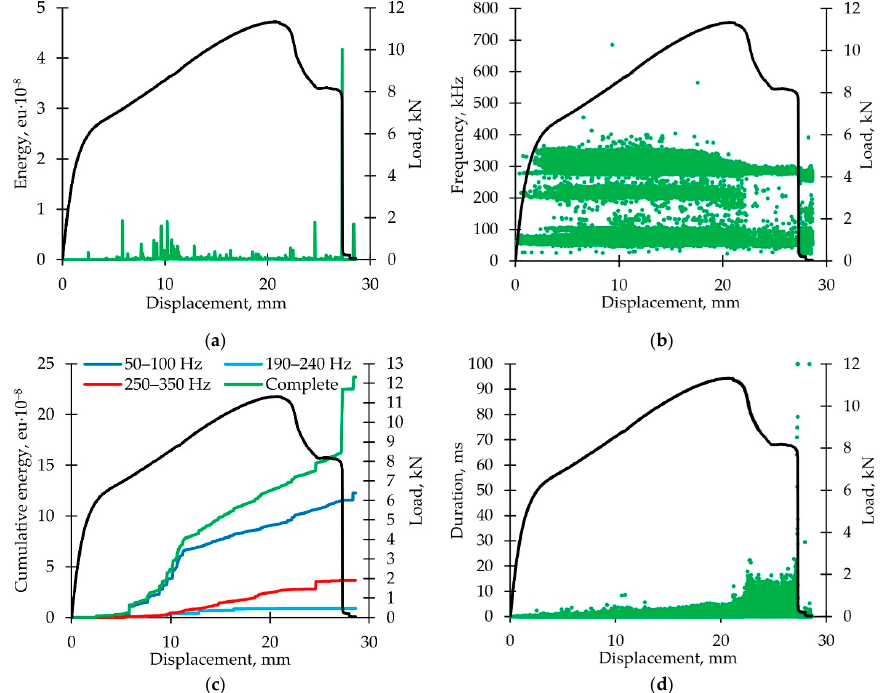
Figure 12. Analysis of acoustic emission signals (loading with additional torsion vibrations): ( a ) Typical distribution diagram of AE signal energy parameter versus displacement; ( b ) typical distribution diagram of AE signal frequency parameter versus displacement; ( c ) typical diagram of cumulative energy dependence on displacement for various AE signal frequencies; ( d ) typical distribution diagram of AE signals durability parameter versus displacement. All the diagrams are accompanied by load diagrams.